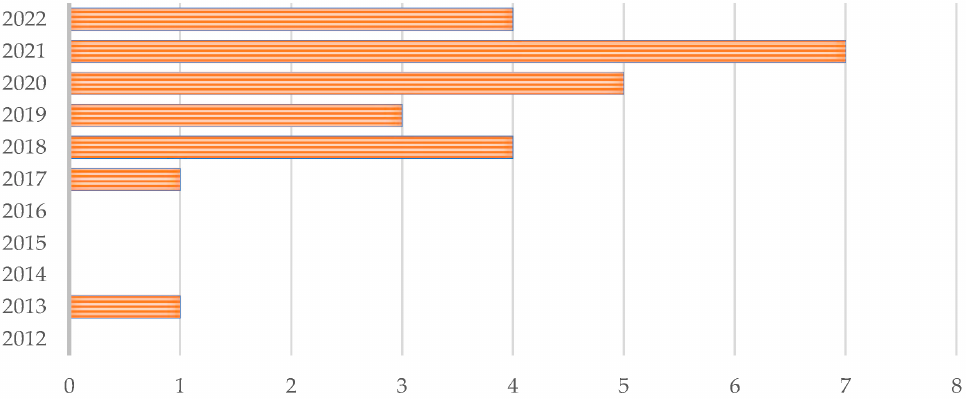
Figure 4. Number of articles.